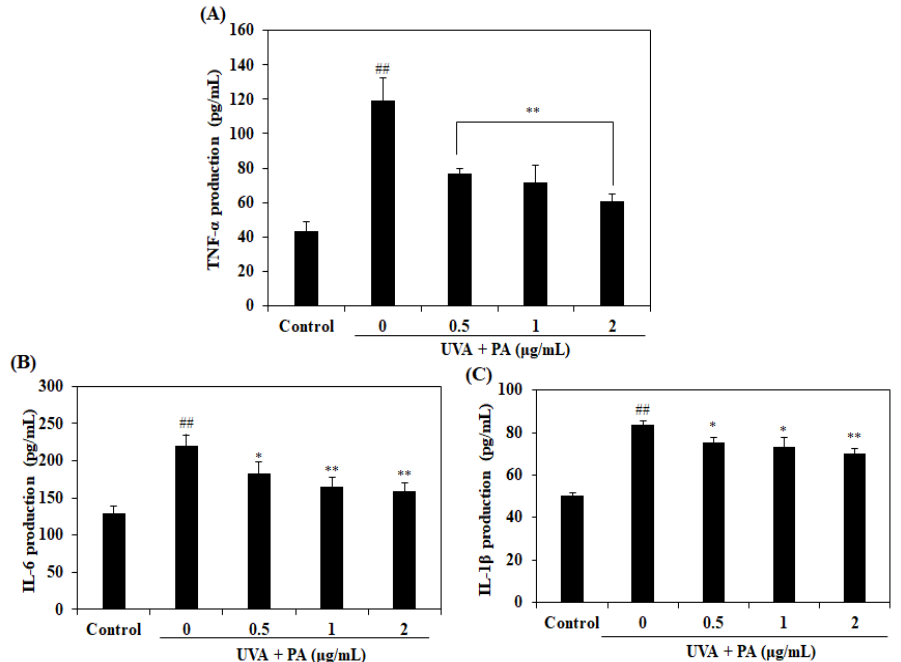
Figure 5. PA inhibits pro-inflammatory cytokine expression in UVA-irradiated HDF cells. Expression of TNF- α in UVA-irradiated HDF cells ( A ); expression of IL-6 in UVA-irradiated HDF cells ( B ); expression of IL-1 β in UVA-irradiated HDF cells ( C ). The expression levels of pro-inflammatory cytokines were measured by the use of commercial ELISA kits, following the manufacturer’s instructions. The values are expressed as the mean ± SD in triplicate experiments. ## p < 0.01 indicates a significant di ff erence compared to the control group. * p < 0.05 and ** p < 0.01 indicate a significant di ff erence compared to the only UVA-irradiated groups.